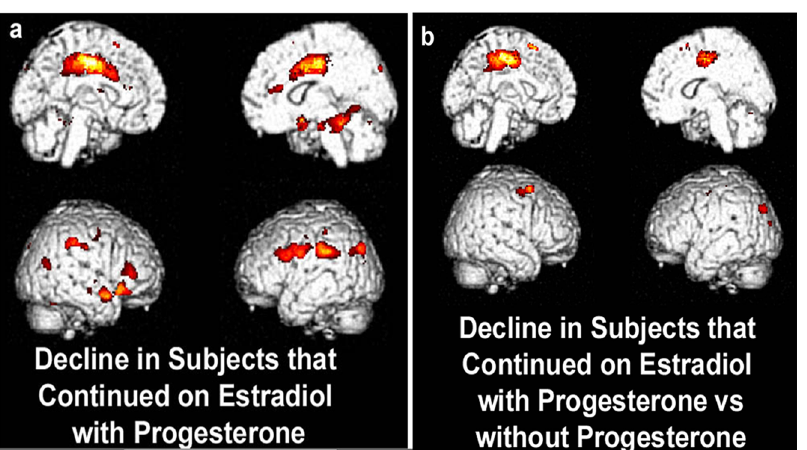
Figure 5. HT + women continuing on 17 b -E with concurrent progesterone demonstrated decreased metabolism with the statistical cluster mapping from the lateral parietotemporal cortex, extending medially through the brain into the posterior cingulate. The posterior cingulate was the most significantly different metabolic area between subjects continuing use of opposed 17 b -E versus subjects on unopposed 17 b -E. Color voxels shown above have significance of p , 0.01 with crosshairs.